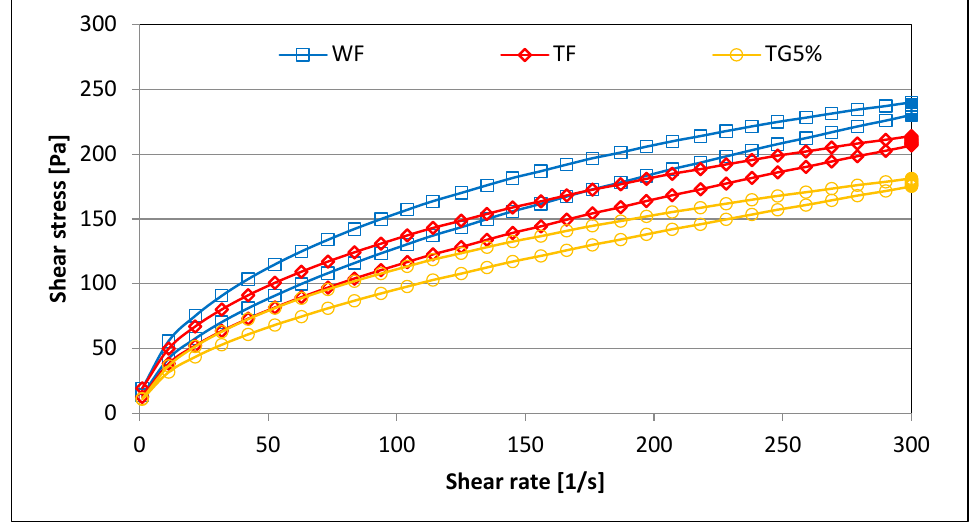
Figure 3. Flow curves of example samples.